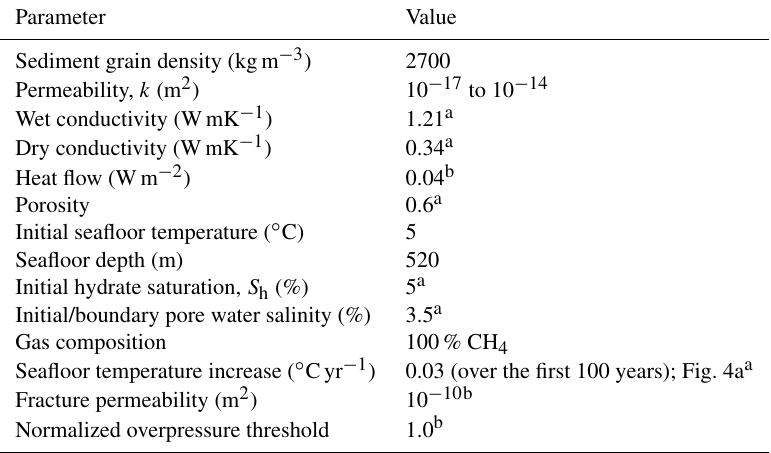
Table 1. Physical properties and T + H-GeoMech simulation parameters (for additional information, see Stranne et al., 2017).